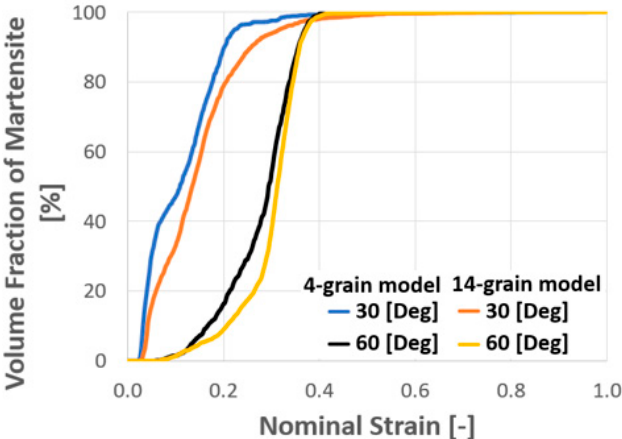
Figure 13. The volume fraction of martensite versus nominal strain under various initial crystallo- graphic orientations in the parent phase.